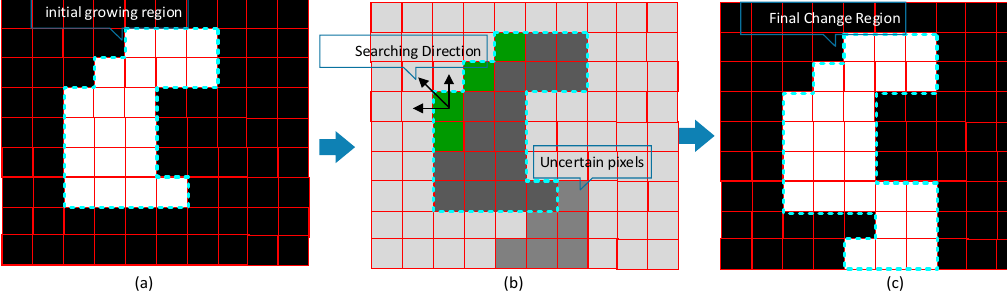
Figure 7. Example of the modified RGA: ( a ) IGR represented by dotted lines in the BCDM; ( b ) seed pixel and its related searching direction in FCMI; and ( c ) final extended change region.